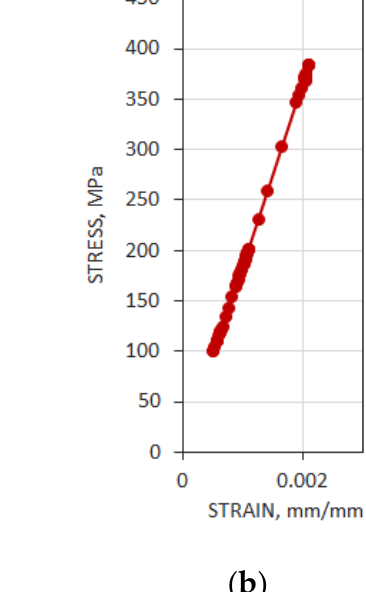
Figure 12. The ( a ) stress versus time and ( b ) stress versus strain relationships for the MC SLOW cold startup computational model, with a decreased rate of change of steam temperature.